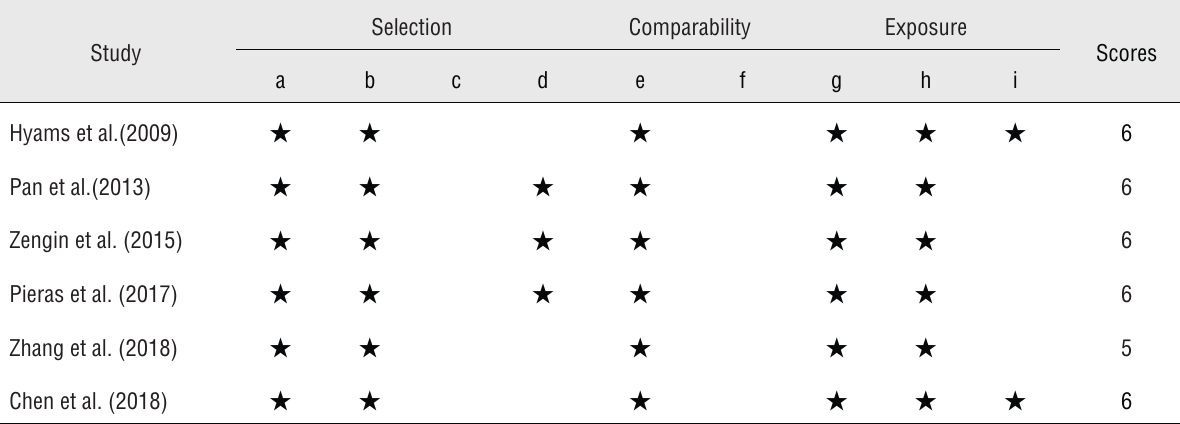
Table 3 - Risk of bias assessment for included retrospective controlled